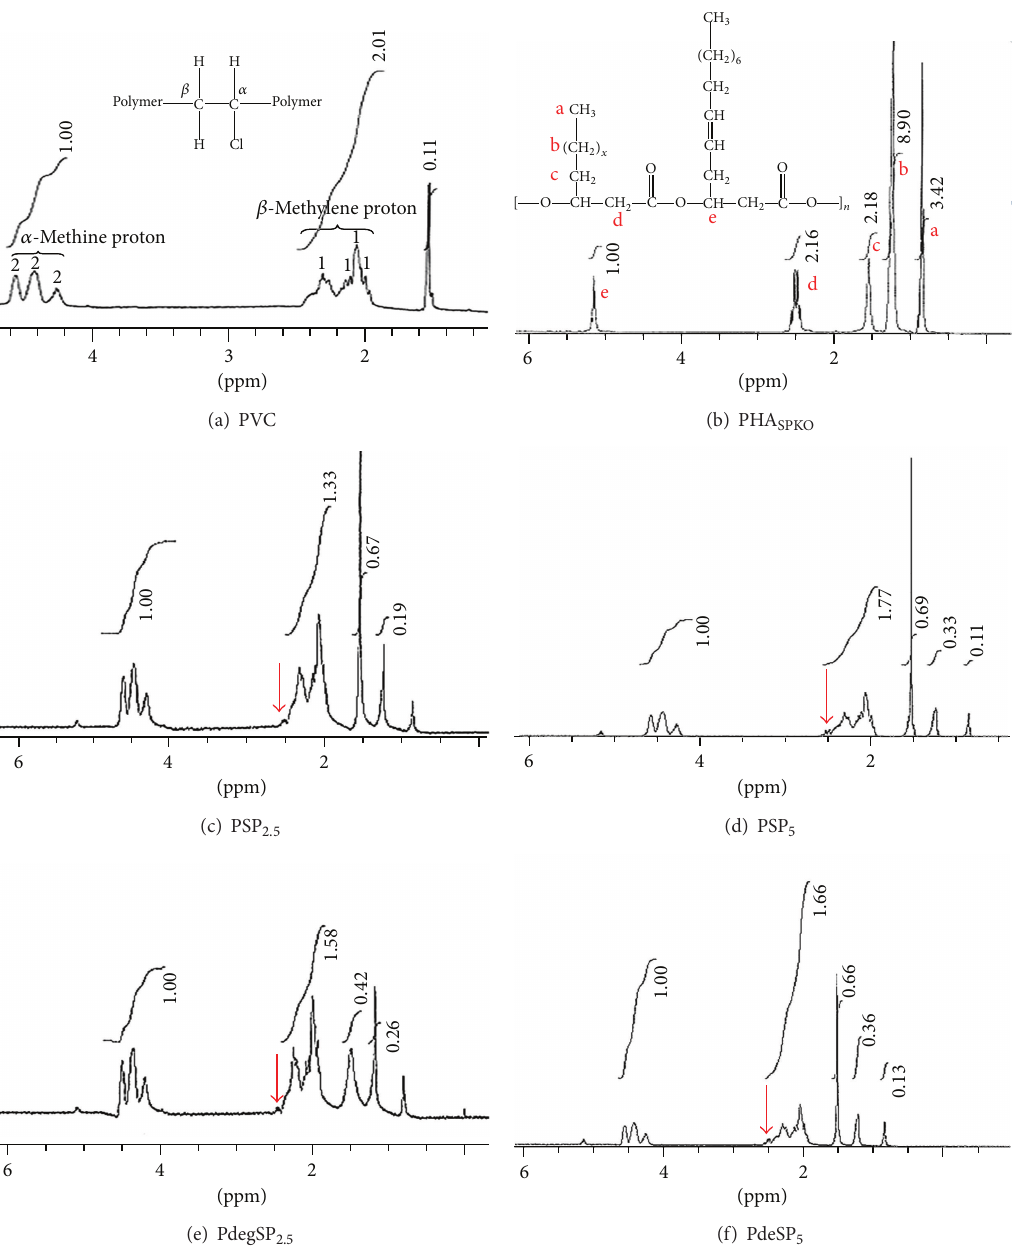
PVC/PHA and PVC/degPHA blend. This peak was